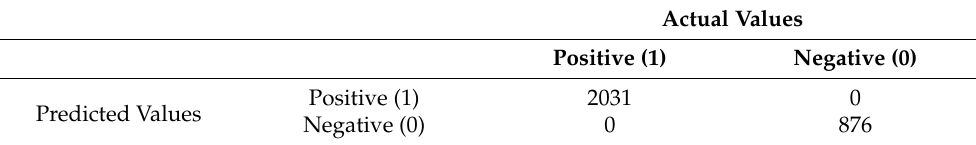
Table 12. Adaboost confusion